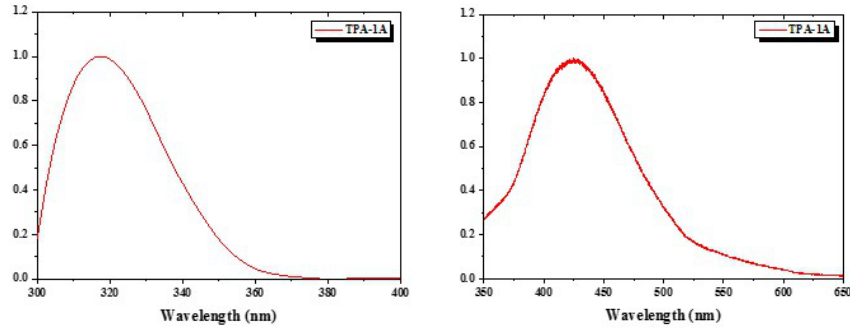
Figure 3. Ultraviolet visible ( UV–VIS) absorption and photoluminescent spectra of TPA-1A.